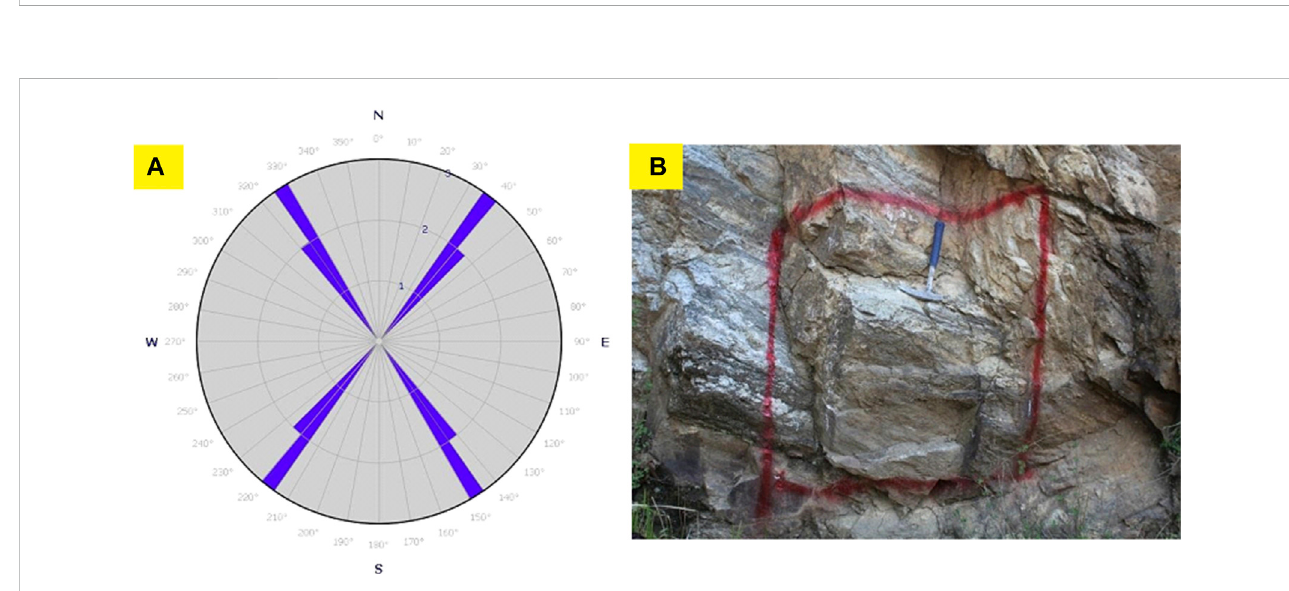
FIGURE 5 (A) Orientation of joints. (B) Low joint density rocks.